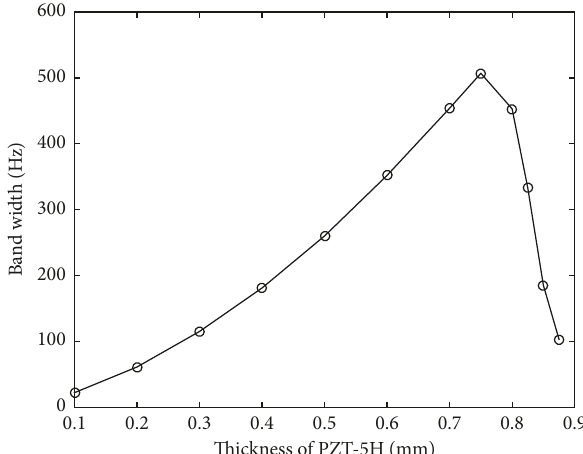
Figure 14: Bandwidth vs. thickness of PZT-5H.